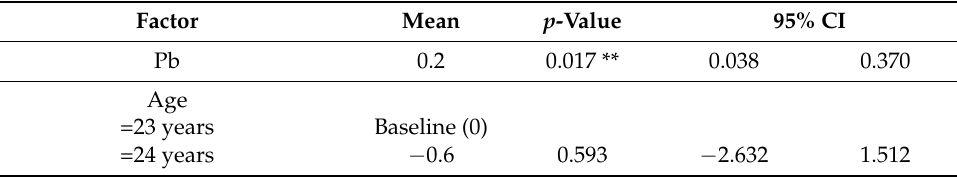
Table 5. Multivariable model of the association between anger and bone lead, after adjusting for study